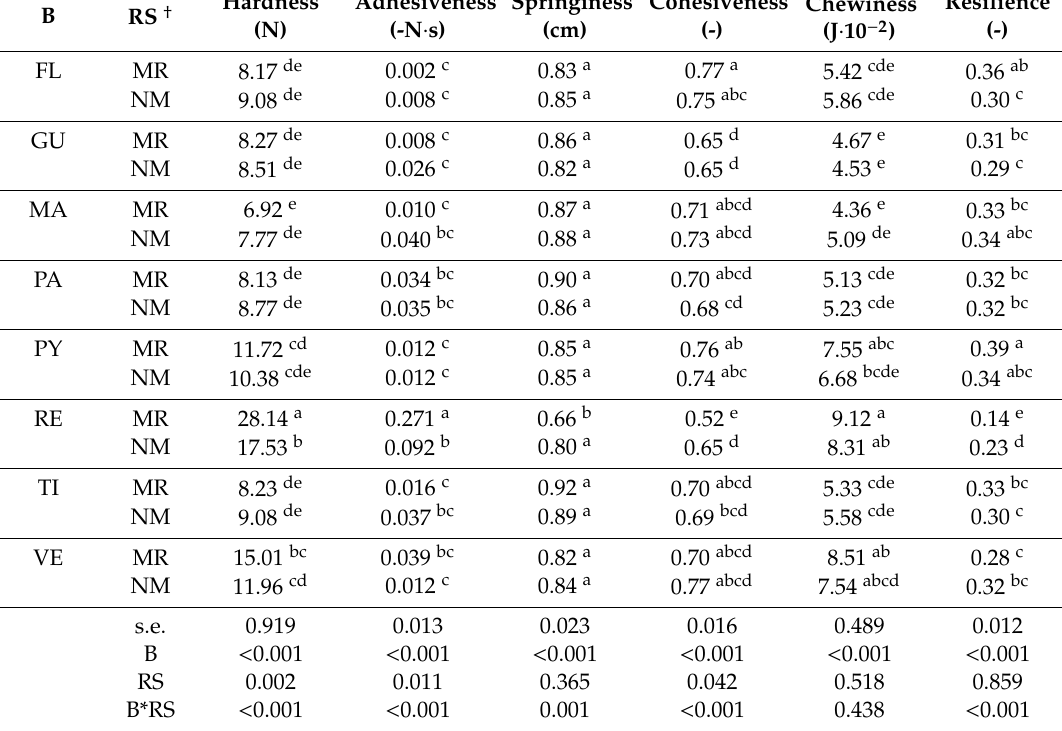
Table 4. Texture profile of cooked longissimus lumborum muscle of suckling kids reared with milk replacer (MR) or natural milk from their dams (NM).